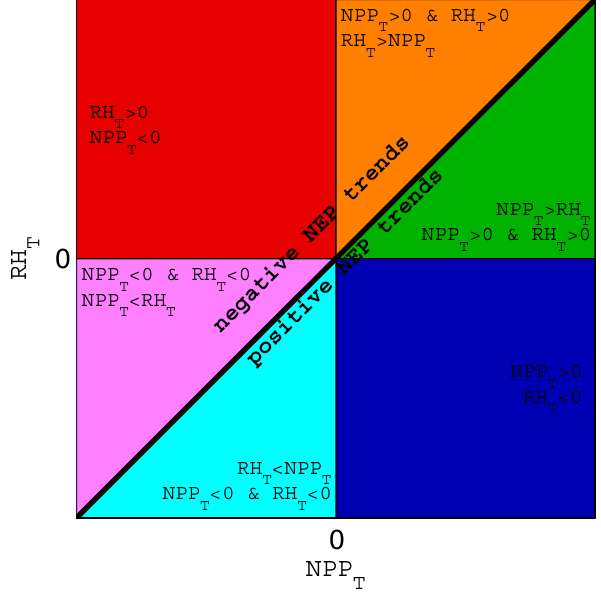
Fig. 2. Abacus of NEP T decomposition into NPP and R H trends: NPP T and RH T ,